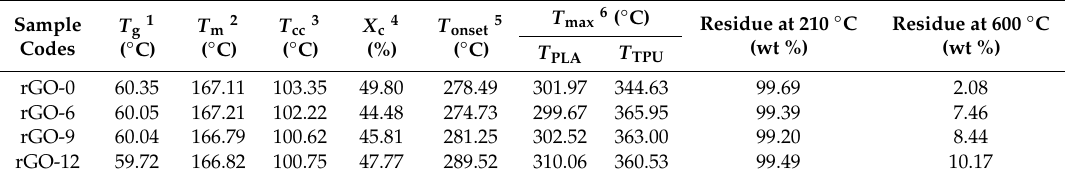
Table 2. Torque rheological parameters: the equilibrium torque ( T e ) and the shear heat ( Δ T ) of the redox graphene nanoplatelet (rGO)/polylactic acid (PLA) composites with different rGO contents.